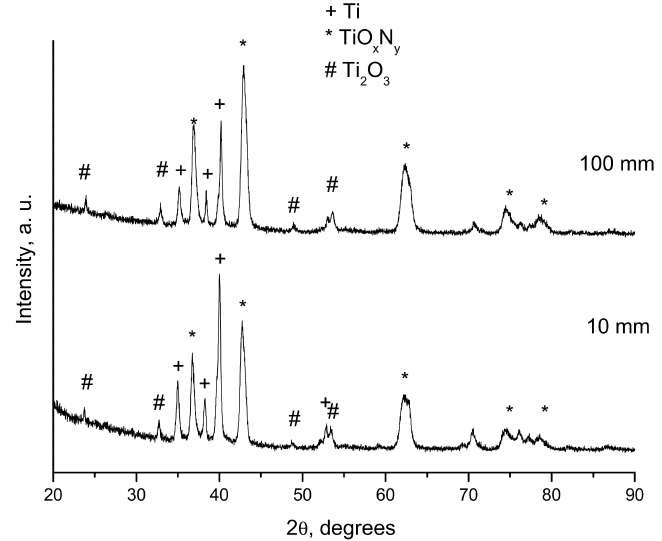
Figure 2. XRD patterns of deposits obtained by detonation spraying of titanium (carrier gas—air, explosive charge 25%, k = 1.1, spraying distances 10 mm and 100 mm). These results were obtained in a study reported in Ref. [29].